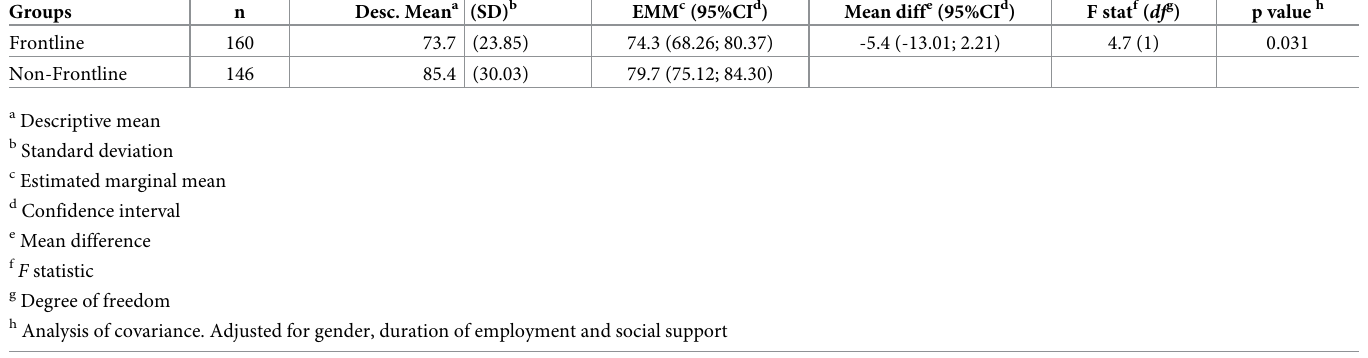
Table 4. Comparison of vicarious traumatization levels between frontline and non-frontline healthcare providers.